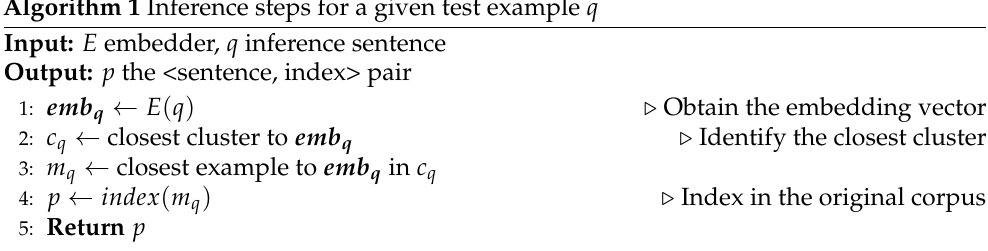
Algorithm 1 Inference steps for a given test example